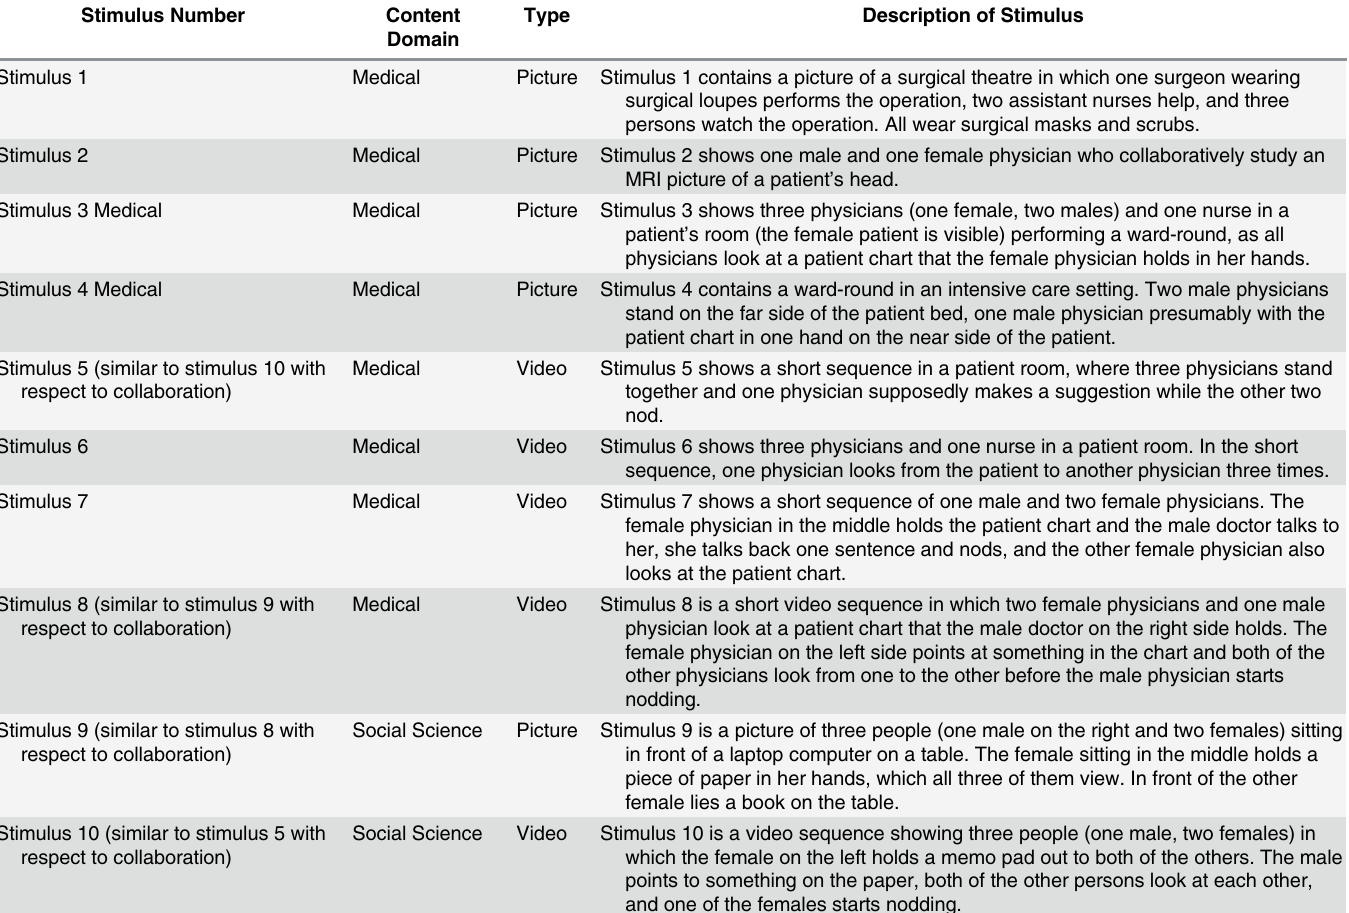
Table 4. Description of the stimuli used in Study 2. The stimuli which are similar with respect to collaboration, but differ in content domain and superficial attributes are marked